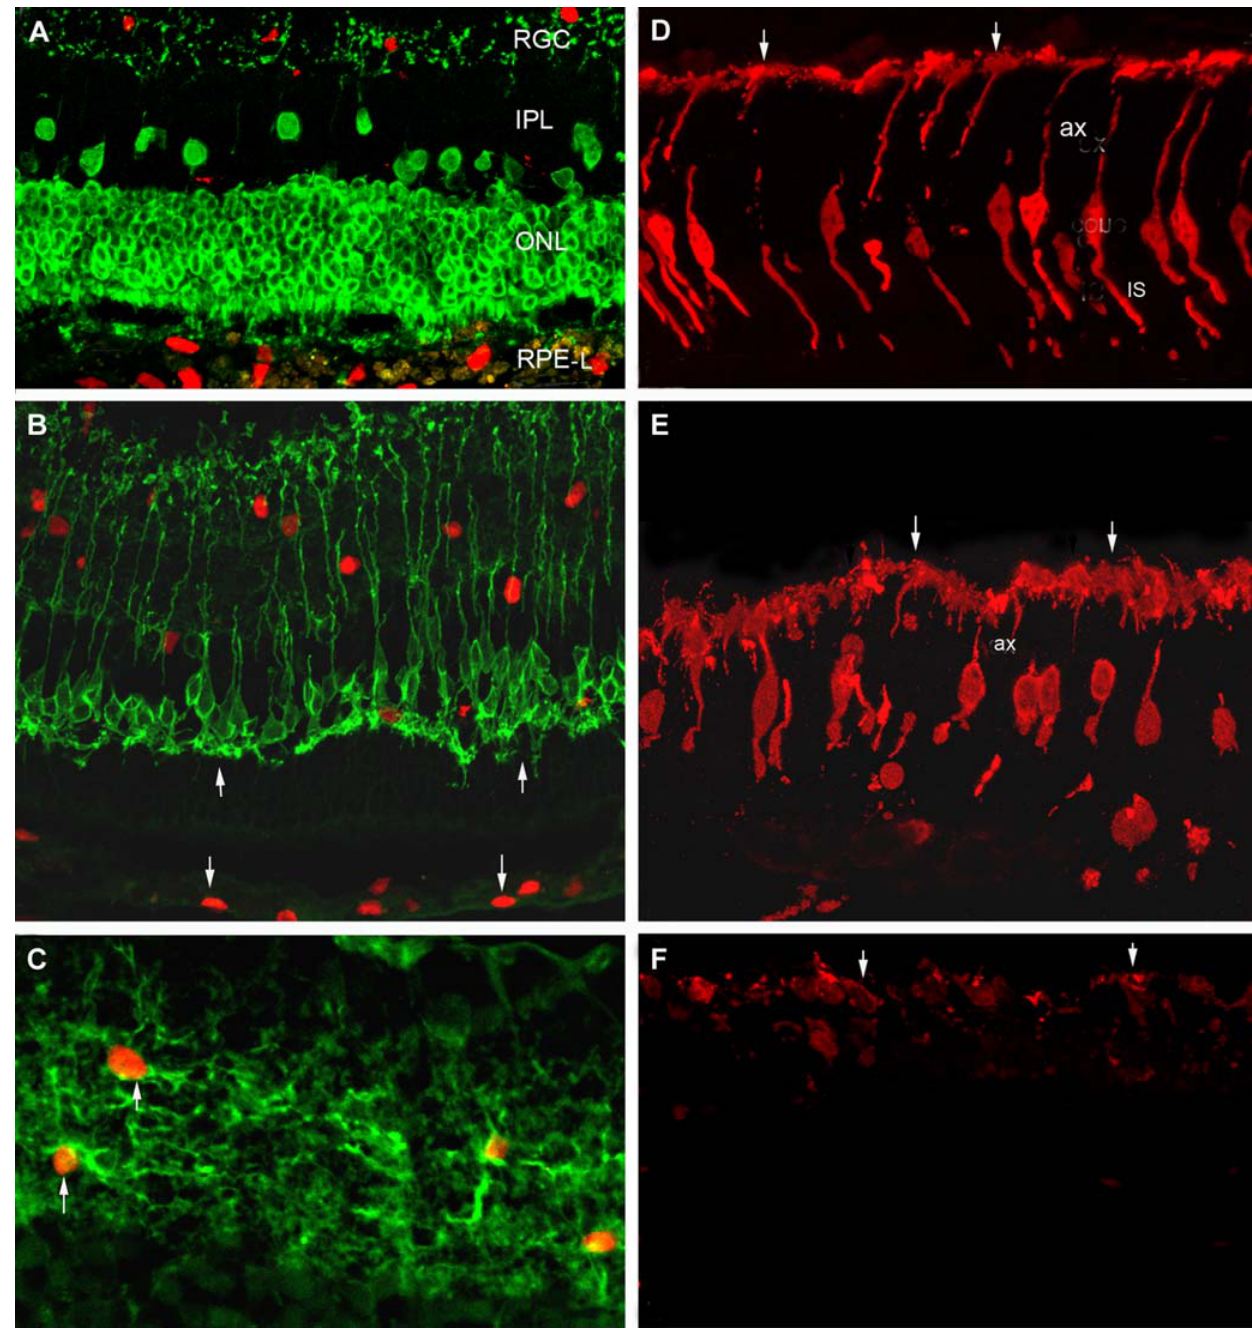
Figure 6. Transplanted human neural progenitors express nestin in vivo and partially preserve host cone structure. Confocal images of P150 dystrophic retina transplanted with hNPC ctx –GDNF and double stained with antibodies against human nuclear antigen ( red ) and either (A) recoverin, a photoreceptor and cone bipolar cell marker ( green ), or (B) protein kinase C a (PKC a ), a bipolar cell marker ( green ). Down arrows point to subretinal donor cell nuclei in panel B, while up arrows point to preserved dendrites of host rod bipolar cells. Note the location of donor cell nuclei in both the inner retina and subretinal space. (C) Confocal image of P150 dystrophic inner retina transplanted with hNPC ctx –GDNF and double stained with antibodies against nestin, a neural stem and progenitor cell marker ( green ) and human nuclear antigen ( red ). (D) Confocal image of non-dystrophic, control retina stained with cone arrestin antibody ( red ) showing a normal cone photoreceptor profile (IS: inner segments; ax: axon; arrows point to cone pedicles). (E) P150 dystrophic retina transplanted with hNPC ctx –GDNF and stained with cone arrestin antibody showing morphology of rescued cone photoreceptors ( arrows point to cone pedicles). (F) Sham-operated retina at P150 stained with cone arrestin antibody ( arrows point to rare remaining cone cell bodies). Results at P150 from retina transplanted with hNPC ctx were similar to those receiving hNPC ctx –GDNF. IPL: inner plexiform layer; ONL: outer nuclear layer; RGC: retinal ganglion cell layer; RPE-L: RPE-like layer.